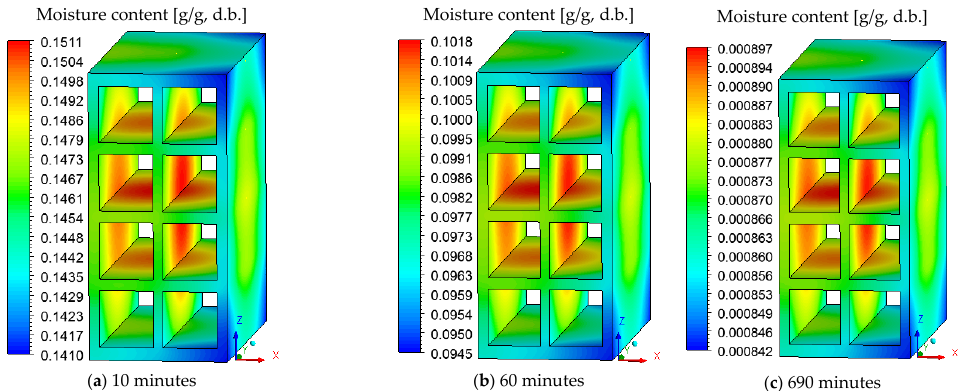
Figure 6. Average water mass of the brick as a function of the drying time (90 and 100 °C). Figure 7 shows the moisture distribution (dry basis) on the brick surface for drying at 90 °C. Due to the flow of drying air from right to left (perpendicular to the ZY plane), it is noted that the superior and inferior vertices on the brick right side, which is in direct contact with the drying air, dries faster compared to other regions of the material. It is also noted that the surface that characterizes the hollow region of the ceramic brick remains wetter than the others, due to the low air flow velocity in this region. This difference in moisture affects the drying process and proves the usefulness of the CFD technique for this purpose. From the analysis of Figure 7, we state that a 90-degree rotation of the ceramic brick around the Z axis would favor the flow of air in the hollow region and would reduce the difference between the moisture observed on the surface. Thus, due to the position of the material inside the oven, an asymmetric drying occurs. In simulations where only the domain of ceramic brick is considered [4,23,29–31], it is not possible to observe the asymmetry in the variable at the surface of the brick. Asymmetric dehumidification is important to study, as it can cause defects in the brick during burning, such as cracks and deformations.